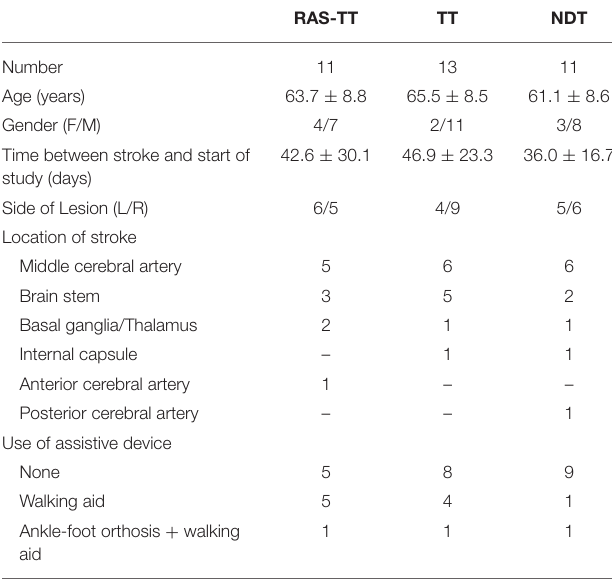
TABLE 1 | Subject data with location of stroke and use of assistive device.